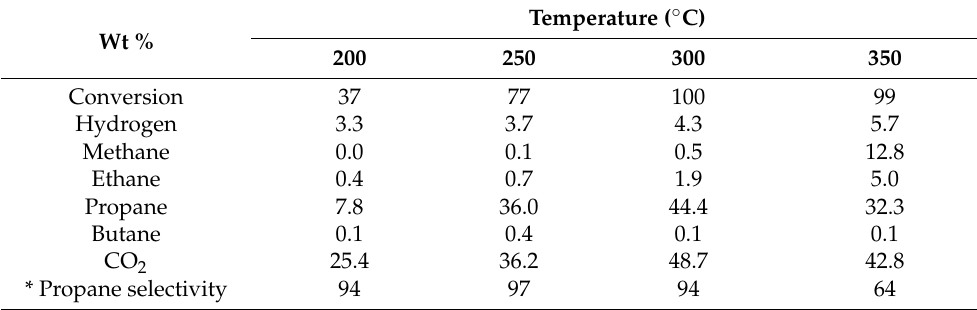
Table 2. Butyric acid conversion and product yields under hydrogen atmosphere at different temperatures. Temperature ( ◦ C) Wt % 200 250 300 350